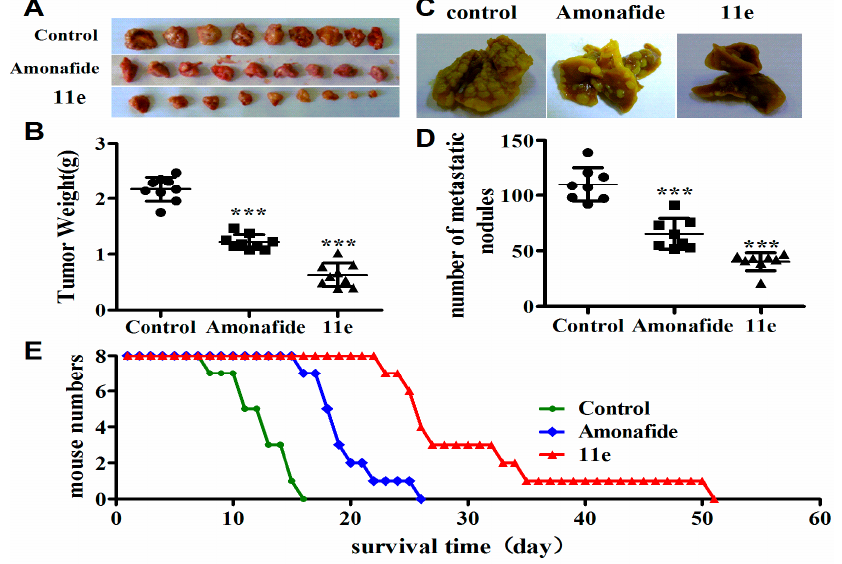
Figure 4. Antitumor activity of 11e was evaluated in vivo. ( A ) Photographs of tumor obtained from each treatment group excised on day 10; ( B ) Tumor weight in subcutaneous model, compared with control: (*** p < 0.001, x ± SD), n = 9; ( C ) Lung metastasis photograph; ( D ) Lung metastasis nodus numbers for pulmonary metastasis in mice treatment with 11e , amonafide, and normal saline. (*** p < 0.001, x ± SD), n = 8; ( E ) The changes of body weight of mice treated with 11e , amonafide, and normal saline; ( E ) Kaplan-Meier curves showing survival of mice treated with 11e , amonafide, and normal saline. Table 3. In vivo lung metastasis inhibitions by 11e .